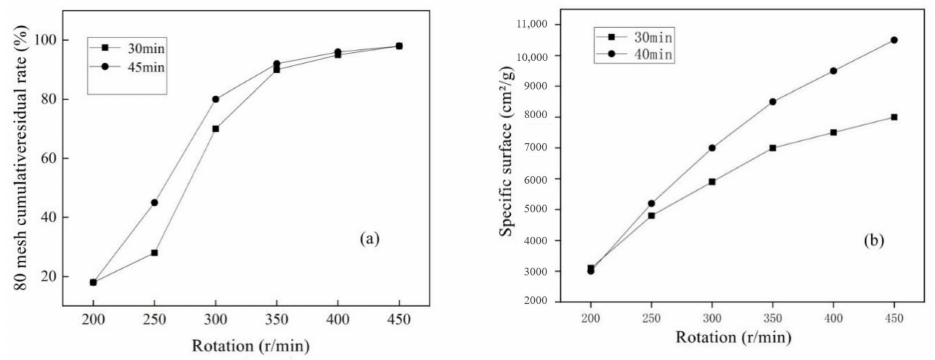
Figure 6. Screen residual rate of 80-mesh ( a ) and specific surface ( b ) versus different rotating speeds of MSWI